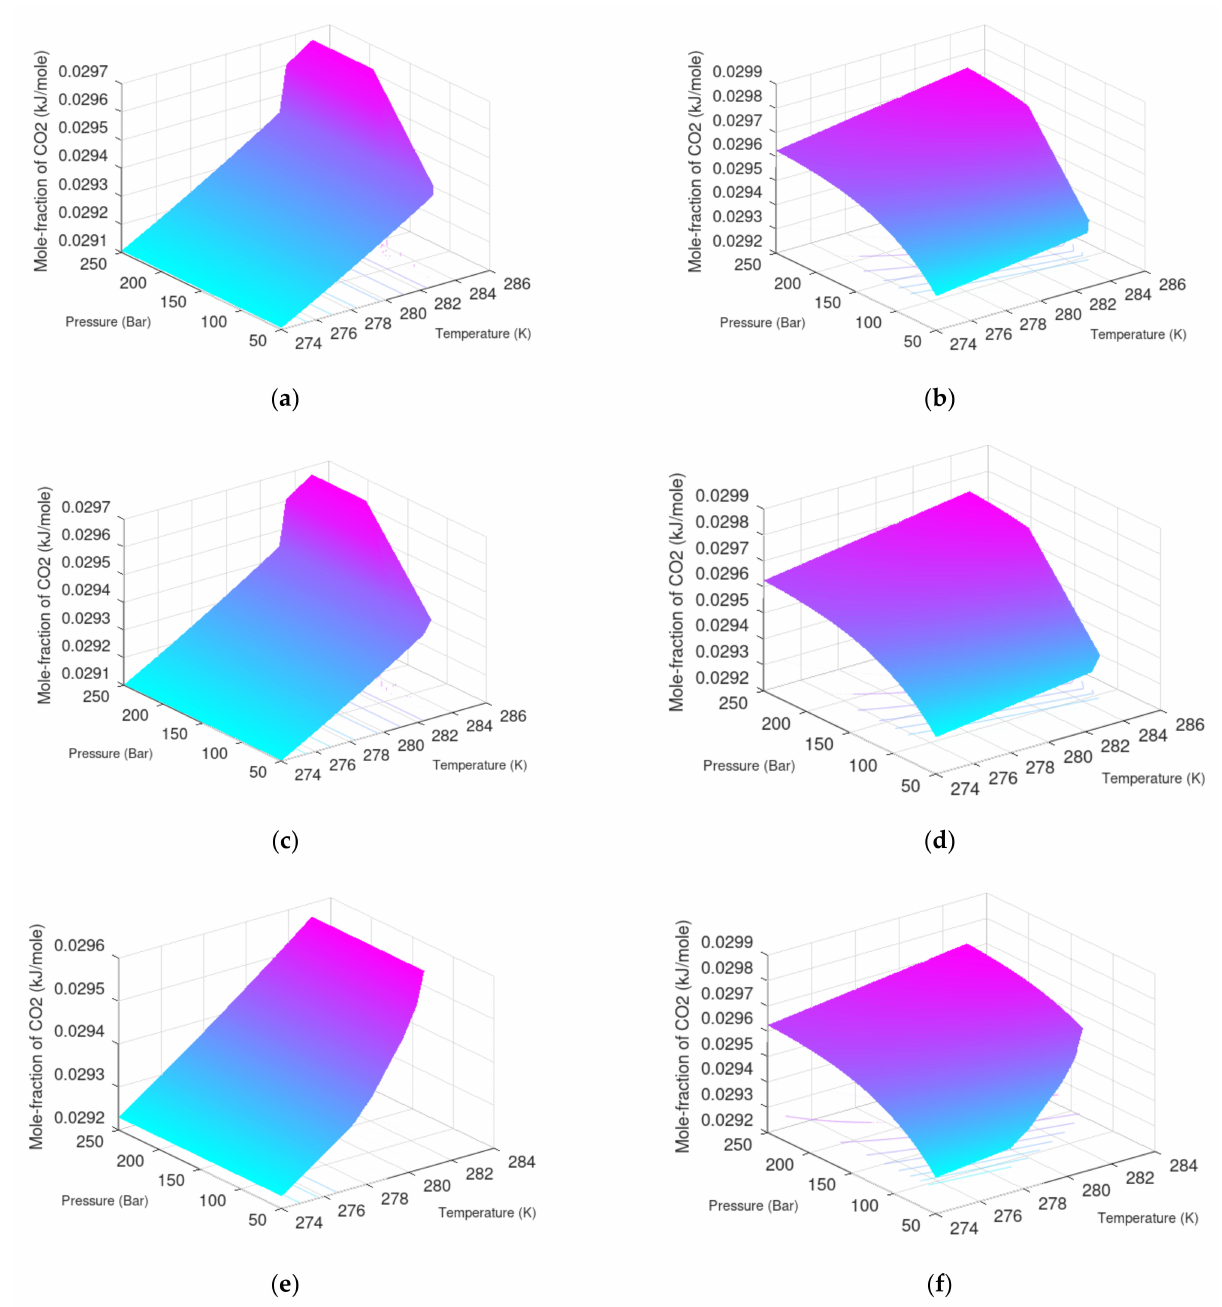
Figure 1. Hydrate stability limit mole-fractions of CO 2 in liquid water for different mole-fractions of NaCl in water ( a , c , e ) and CO 2 solubility as function of temperature and pressure for different mole-fractions of NaCl in water ( b , d , f ). ( a , b ) Mole-fraction NaCl in water 0; ( c , d ) mole-fraction NaCl in water 0.0108; and ( e , f ) mole-fraction NaCl in water